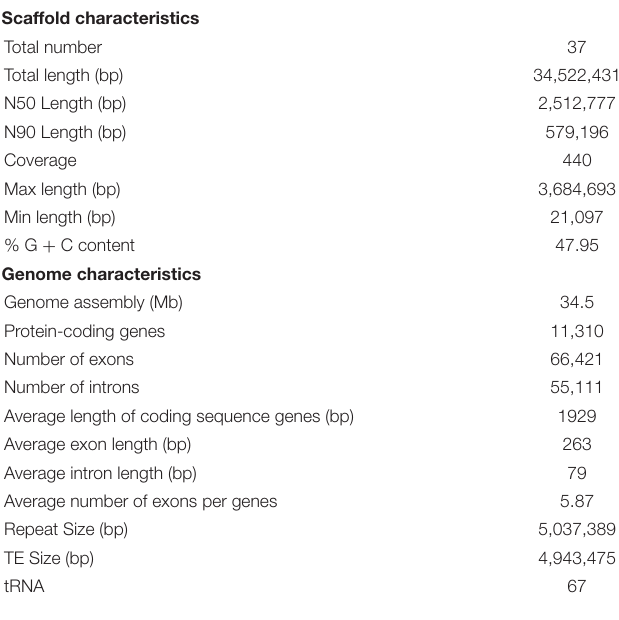
TABLE 1 | Genome assembly and features of S. sanghuang